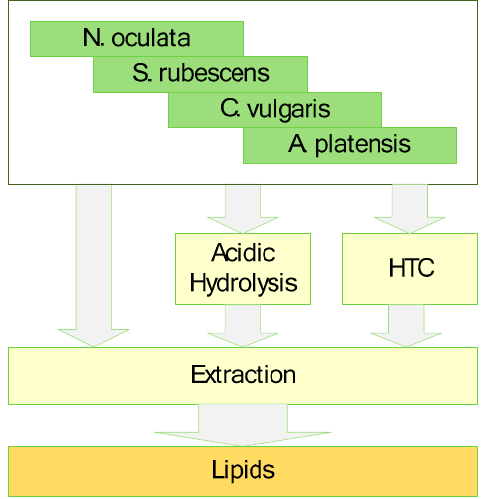
Figure 1. Processing scheme for the comparison of different species.